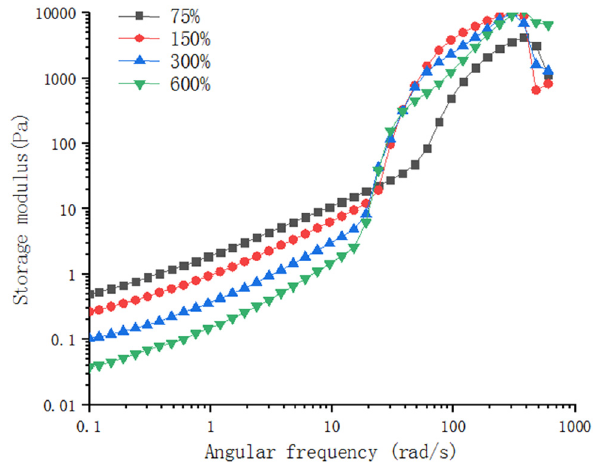
Figure 6: The relationship between the storage modulus and fre - quency of the 0.15% MWCNTs – PVP/SiO 2 – STF